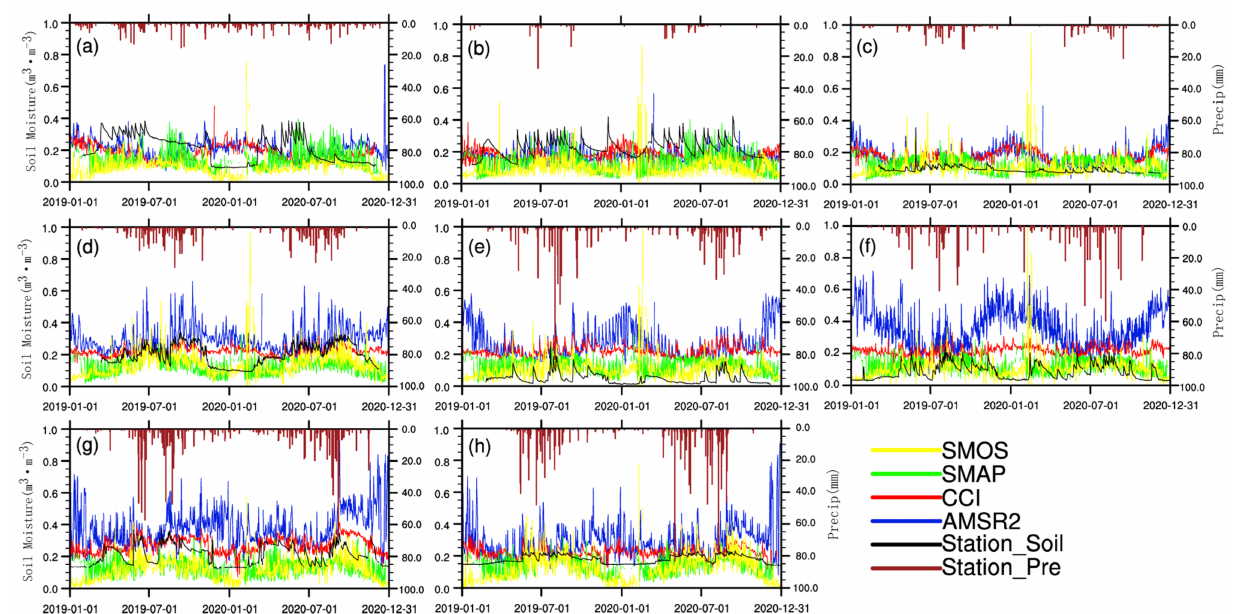
Figure 9. Time series of daily soil moisture (left ordinate axis, curve) and daily precipitation obser- vations (right ordinate axis, histogram) observed and retrieved by eight representative stations in different climate zones. Panels ( a – h ) are data of stations Tacheng, Hotan, Zhangye, Haidong, Yulin, Beijing, Changchun and Ulanhot,